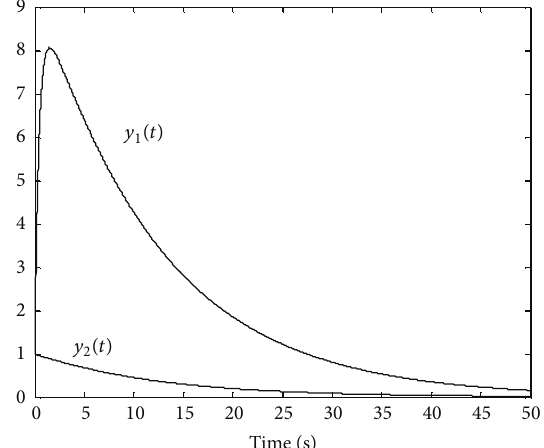
Figure 1: State evolution for the system (75).